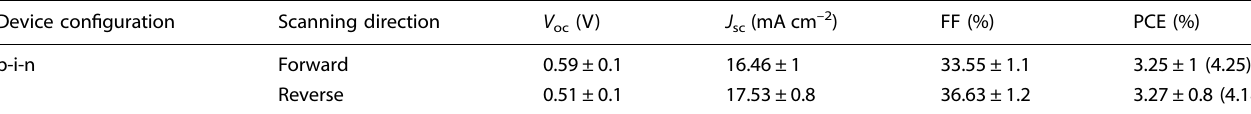
Table 1. Photovoltaic parameters of PSCs with p-i-n con fi guration Device con fi guration Scanning